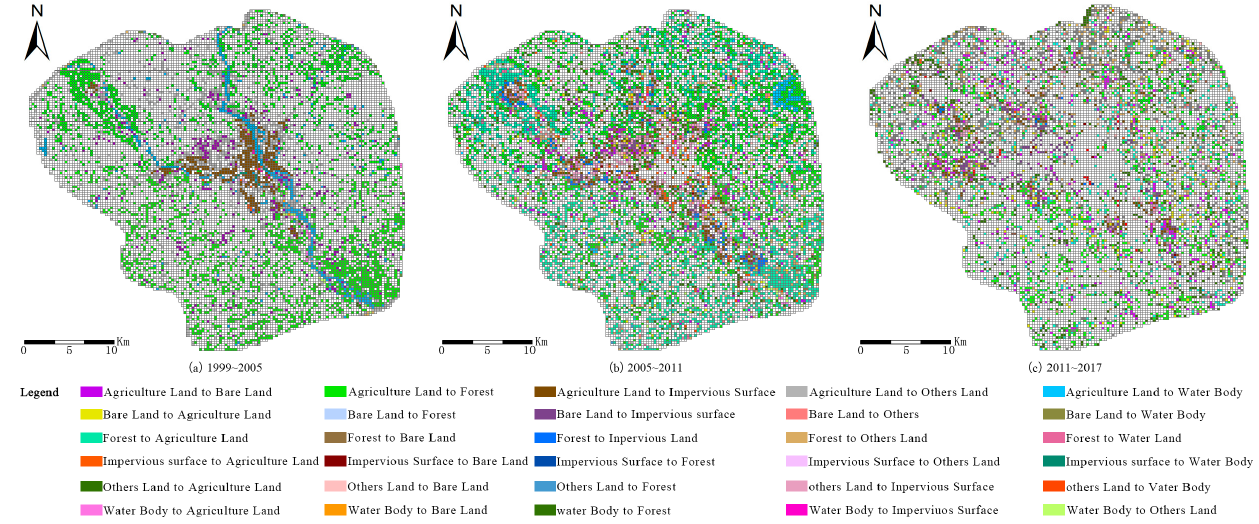
Figure 2. Conversion map of LULC.